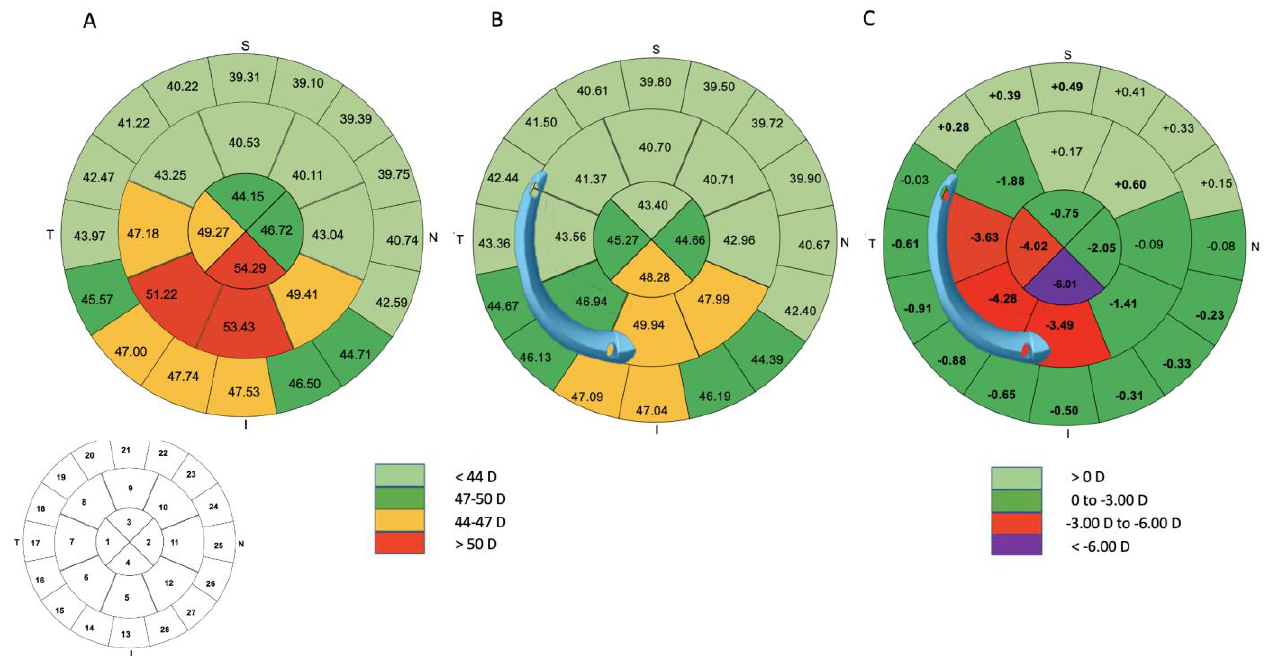
Figure 4. The mean sagittal anterior keratometry in 28 zones in the central 8 mm of the cornea is shown for the examinations performed before surgery ( A ) and 6 months after the implantation of one AJL PRO + ICRS ( B ). The average position of the ring is shown. The averaged differential map ( C ) shows that the flattening effect of the AS-ICRS is greater at the widest end than at the narrowest end. Significant results are shown in bold.